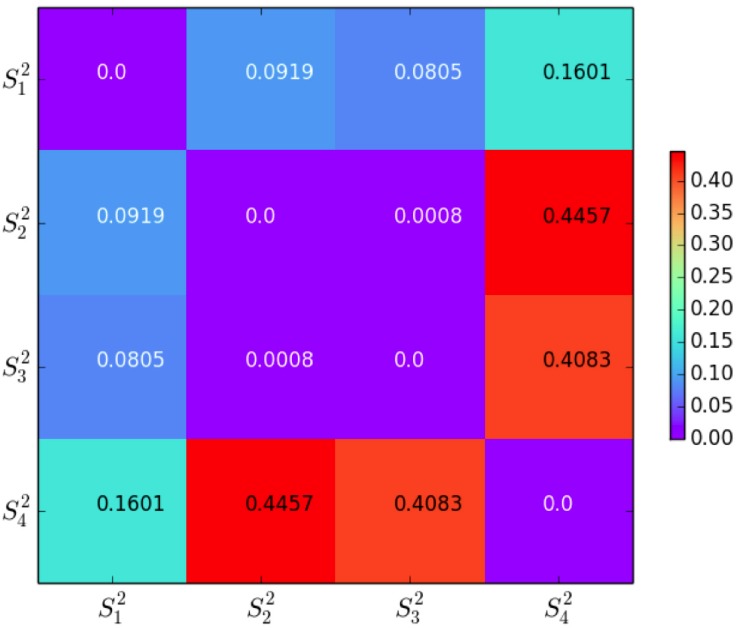
2-dim clusters and TrLogDet distance per dimension.